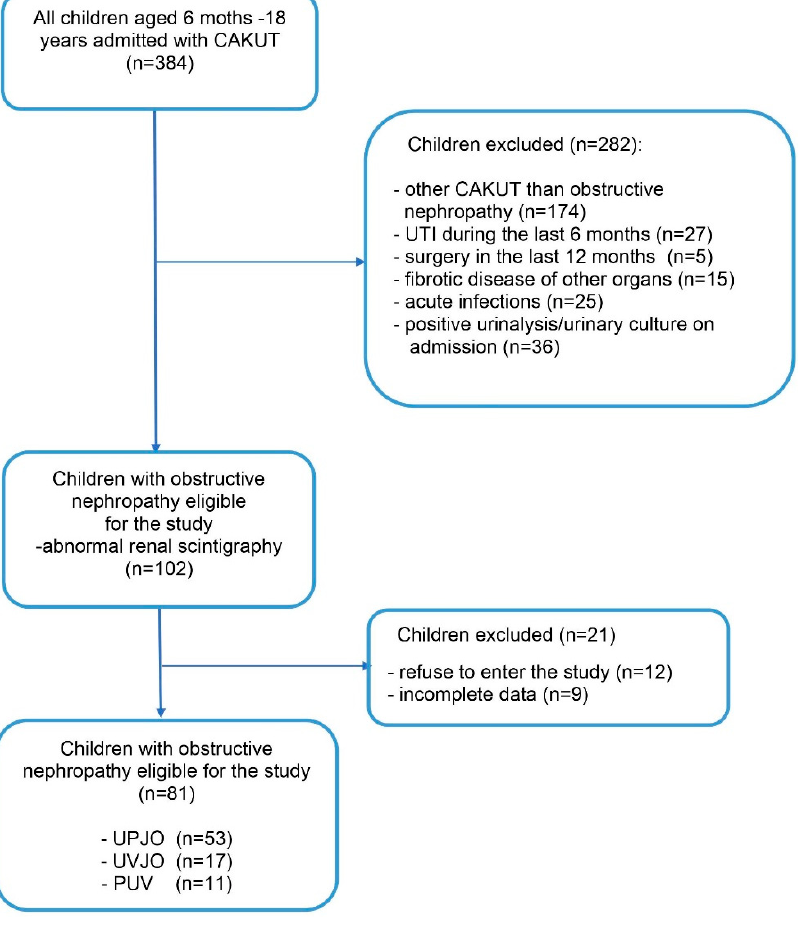
Figure 1. Study flow diagram. CAKUT—congenital anomalies of the kidney and urinary tract; UTI—urinary tract infection; UPJO—ureteropelvic junction obstruction; UVJO—ureterovesical junction obstruction; PUV—posterior urethral valves.